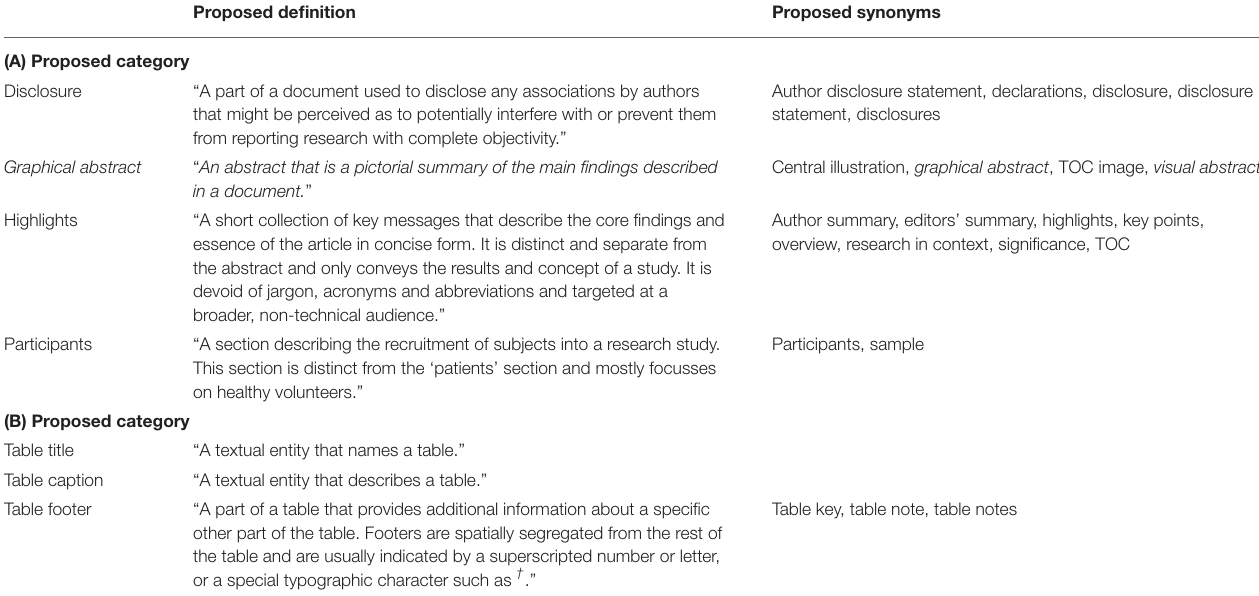
TABLE 3 | (A) Proposed new IAO terms to define publication sections that were derived from analyzing the sections of 2,441 publications. (B) Proposed new IAO terms to define parts of a table section. Elements in italics have previously been submitted by us for inclusion into IAO and added in the v2020-12-09 IAO release.